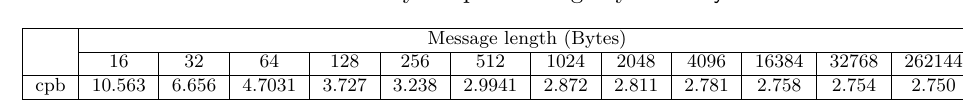
Table 2: Clock cycles per message byte for